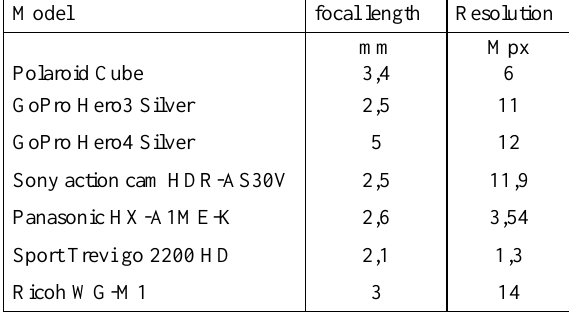
Table 2. Action camera calibration